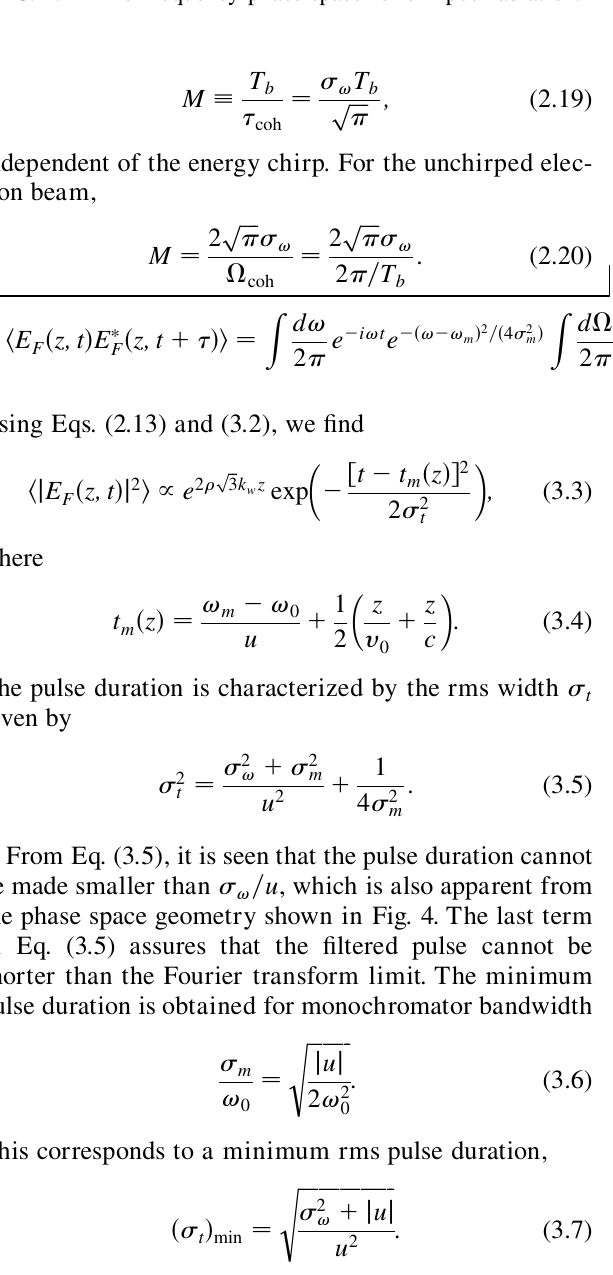
FIG. 4. Time-frequency phase space for chirped